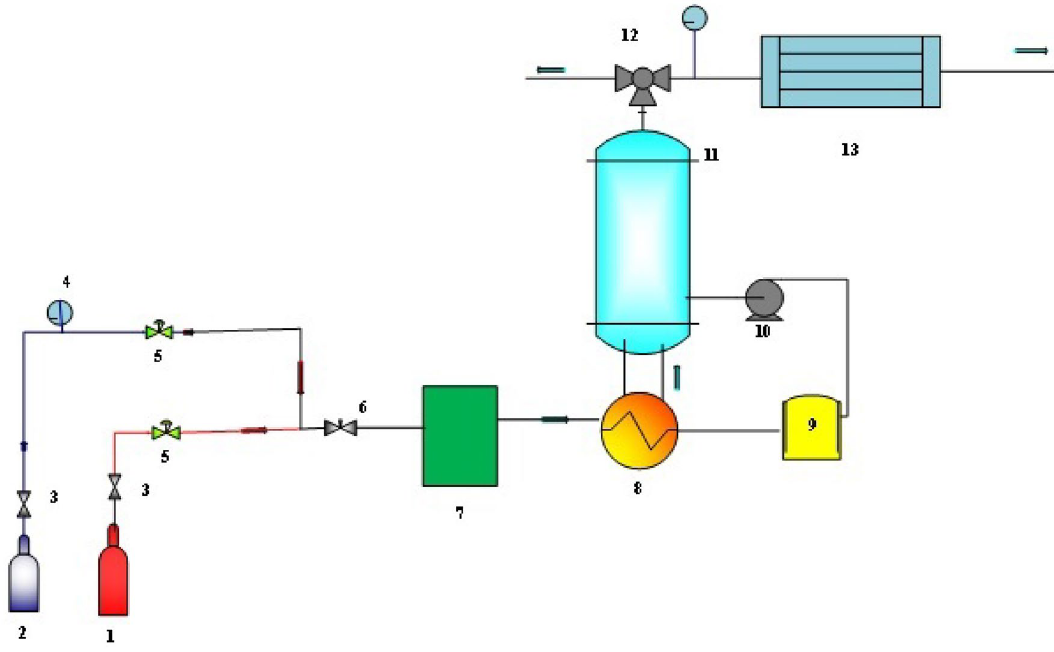
Figure 1. Experimental setup employed in the CO 2 absorption experiments: (1) CO 2 cylinder; (2) N 2 cylinder; (3) Ball valve; (4) Pressure gauge; (5) Flow controller; (6) gate valve; (7) Saturation tank; (8) Heater; (9) Solution tank; (10) Pump; (11) wetted-wall column; (12) Pressure controller; (13) Condenser 75